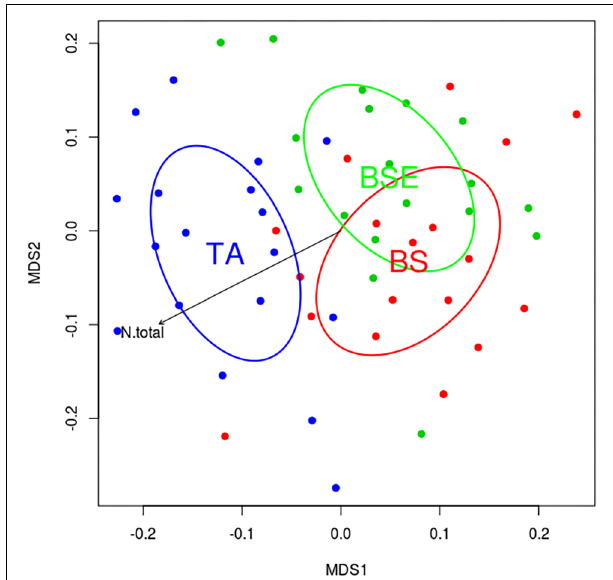
FIGURE 5 | Non-metric multidimensional scaling (NMDS) plots representing similarity between EMF communities of BF root tips in black spruce (BS, red), black spruce + ericaceous shrubs (BSE, green) and trembling aspen (TA, blue) stands. Arrow represents the correlation between N concentration in fir needle and NMDS